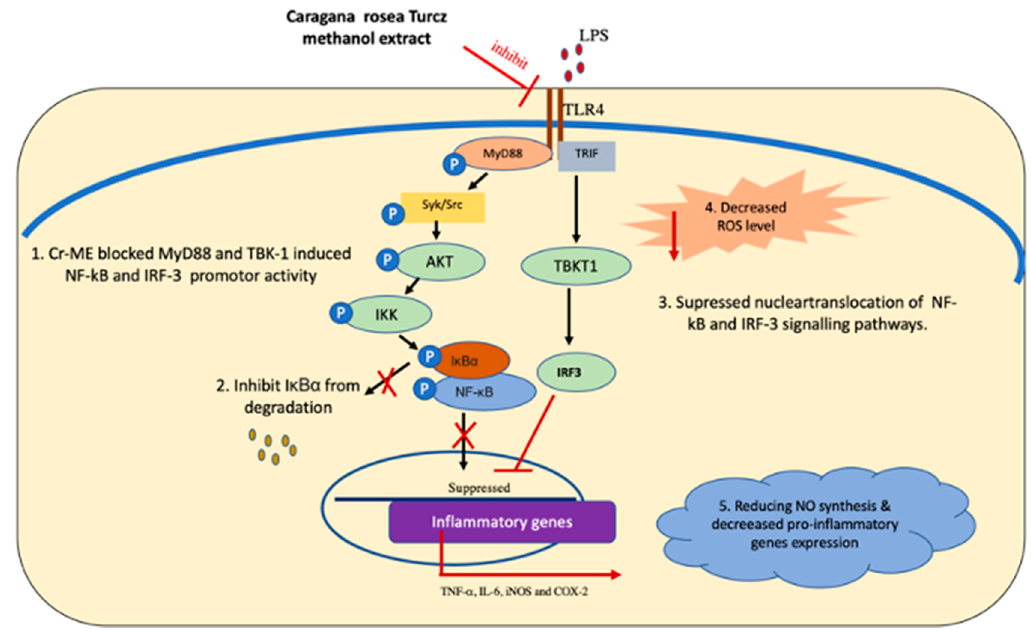
Figure 6. Anti-inflammatory mechanisms of Cr-ME targeting Src in the NF- κ B and TBK1 in IRF3 signaling pathways.